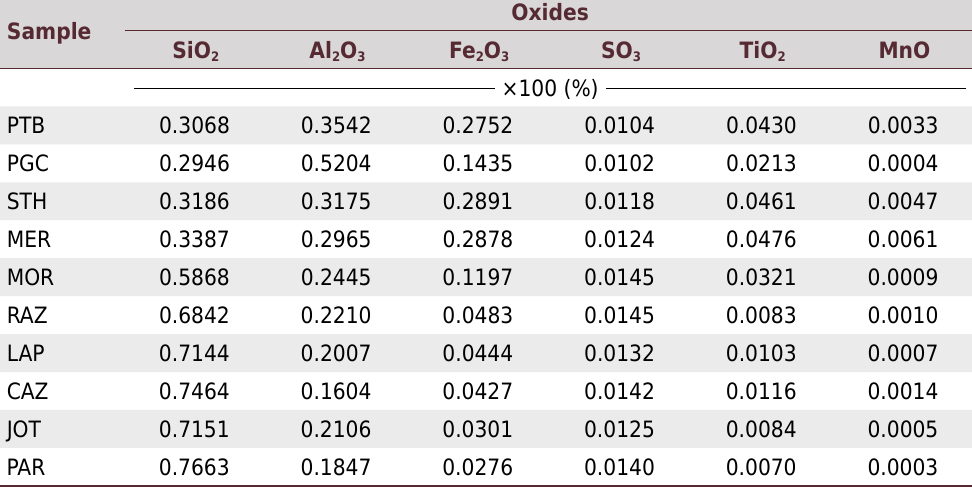
Table 2. Oxide content (most commonly found in all samples) of different soils studied